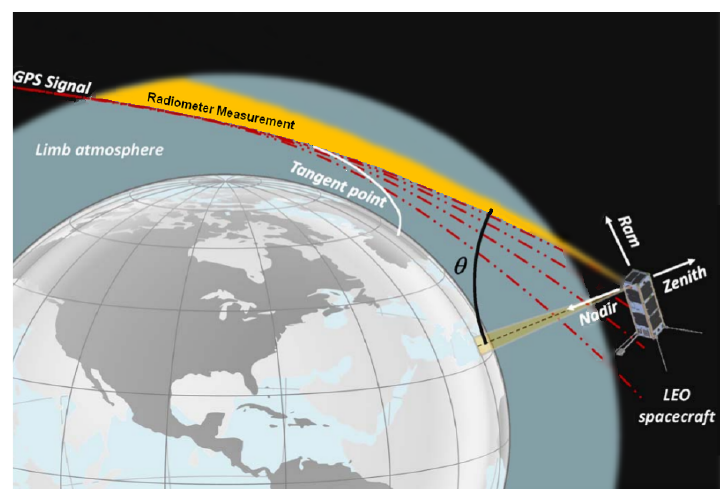
Figure 2. Basic geometry of co-located GNSS-RO microwave radiometer calibration